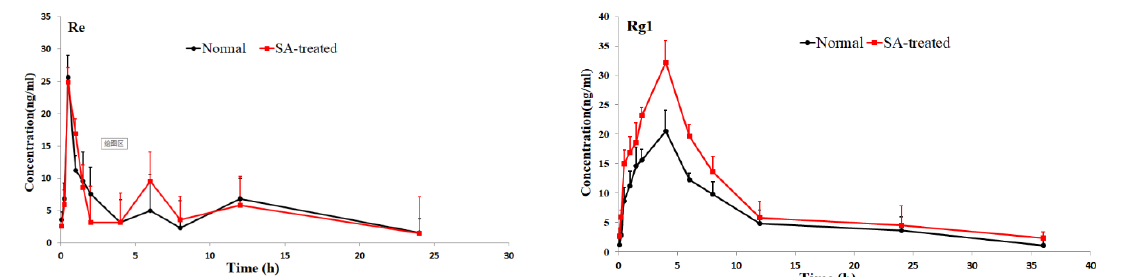
Table 2. Pharmacokinetic parameters of 16 ginsenosides in rat plasma following oral administration of RGS. All data are expressed as mean ± S.D. (n = 5). Compounds